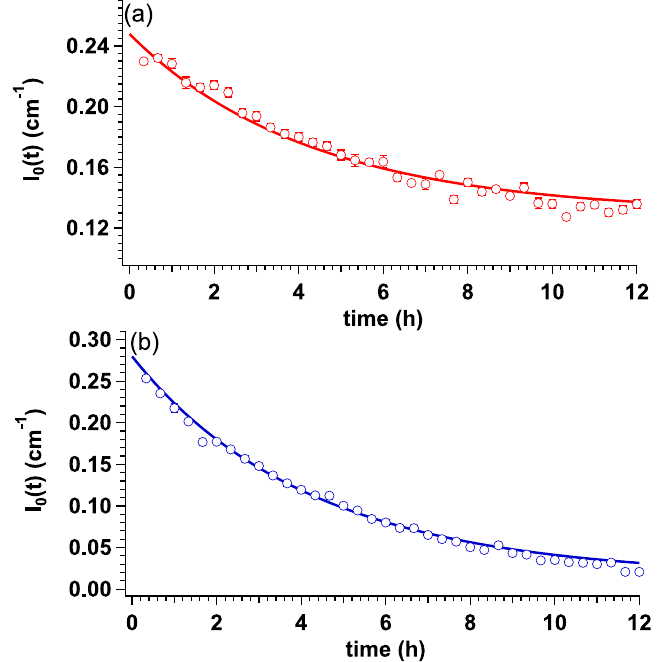
Figure 5. I 0 ( t )s of the dilute and the dense samples, and the calculated curves based on the monomer attaching/ detaching model. ( a ) The red circle and the red solid line correspond to I 0 ( t ) of the dilute sample and the result from the calculation based on the Monomer Attaching/Detaching model, respectively. ( b ) The blue circle and the blue solid line correspond to I 0 ( t ) of the dense sample and the result from the calculation based on the Monomer Attaching/Detaching model, respectively. This figure is prepared by the usage of IGOR Pro 6.34A (https ://www.wavem etric s.com/forum /news-and-annou nceme nts/igor-634a-now-shipp